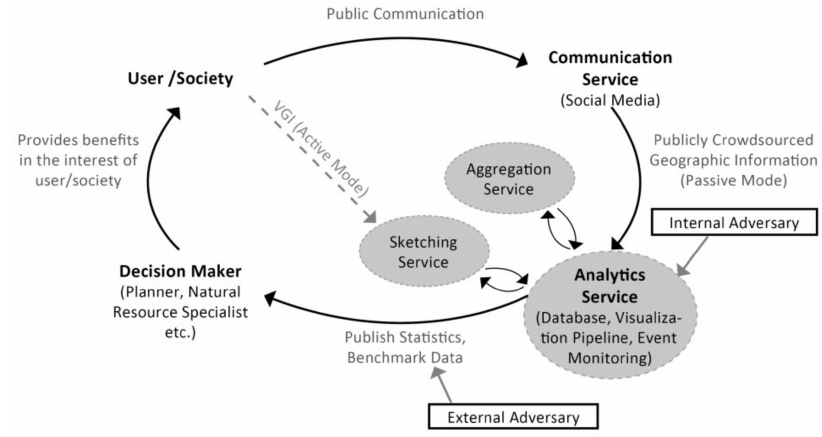
Figure 1. Illustration of the system model and the two cases of possible adversaries discussed in this